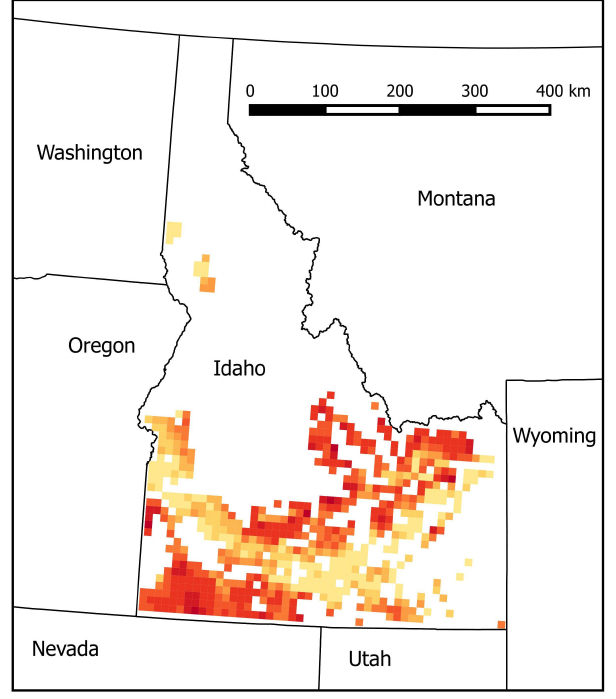
Fig. 6 . Model averaged prediction generated from multiscale occupancy top model set based on the proportion of original 10 km x 10 km grids in sageland and marshland/riparian habitat influencing the probability of occupancy by at least one Short-eared Owl ( Asio flammeus ) during the 2015 breeding season. Color scales represent ( Ψ ) from light orange (0.33) to dark red (0.46).